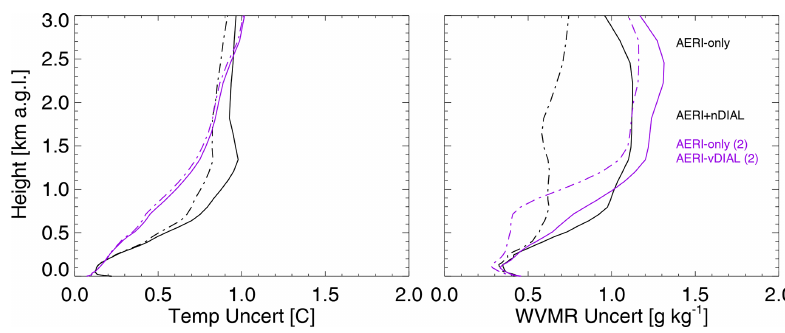
Figure 7. The mean uncertainty in temperature (left) and water vapor mixing ratio (right) for AERI-only (solid lines) and AERI + x DIAL (broken lines) retrievals during Perdigão (black) and SGP (purple), where the former used nDIAL data, and the latter used vDIAL data. Note that different priors were used for the two locations; this impact is seen in the AERI-only retrievals as the noise levels of the two AERIs were